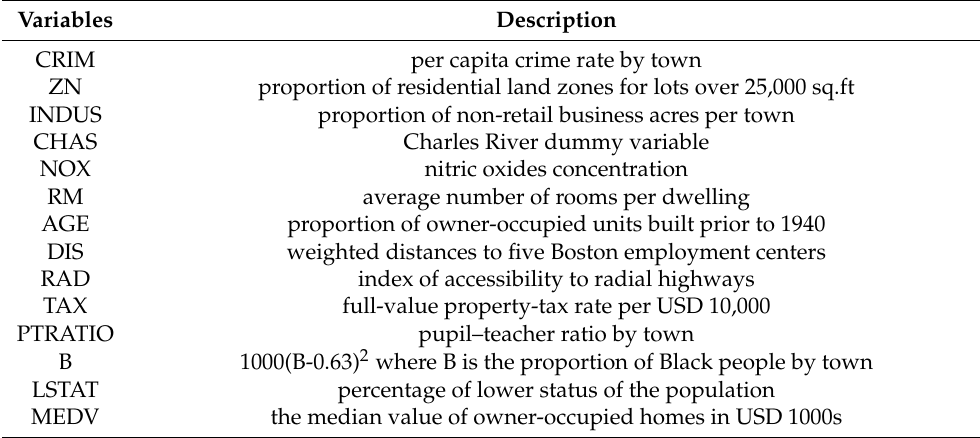
Table 5. Description of the variables in Boston housing price